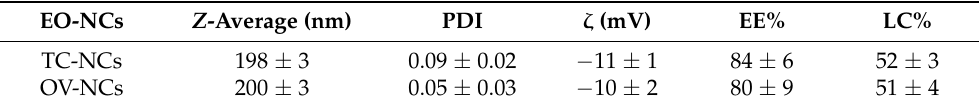
Table 2. Physicochemical Characterization of essential oil